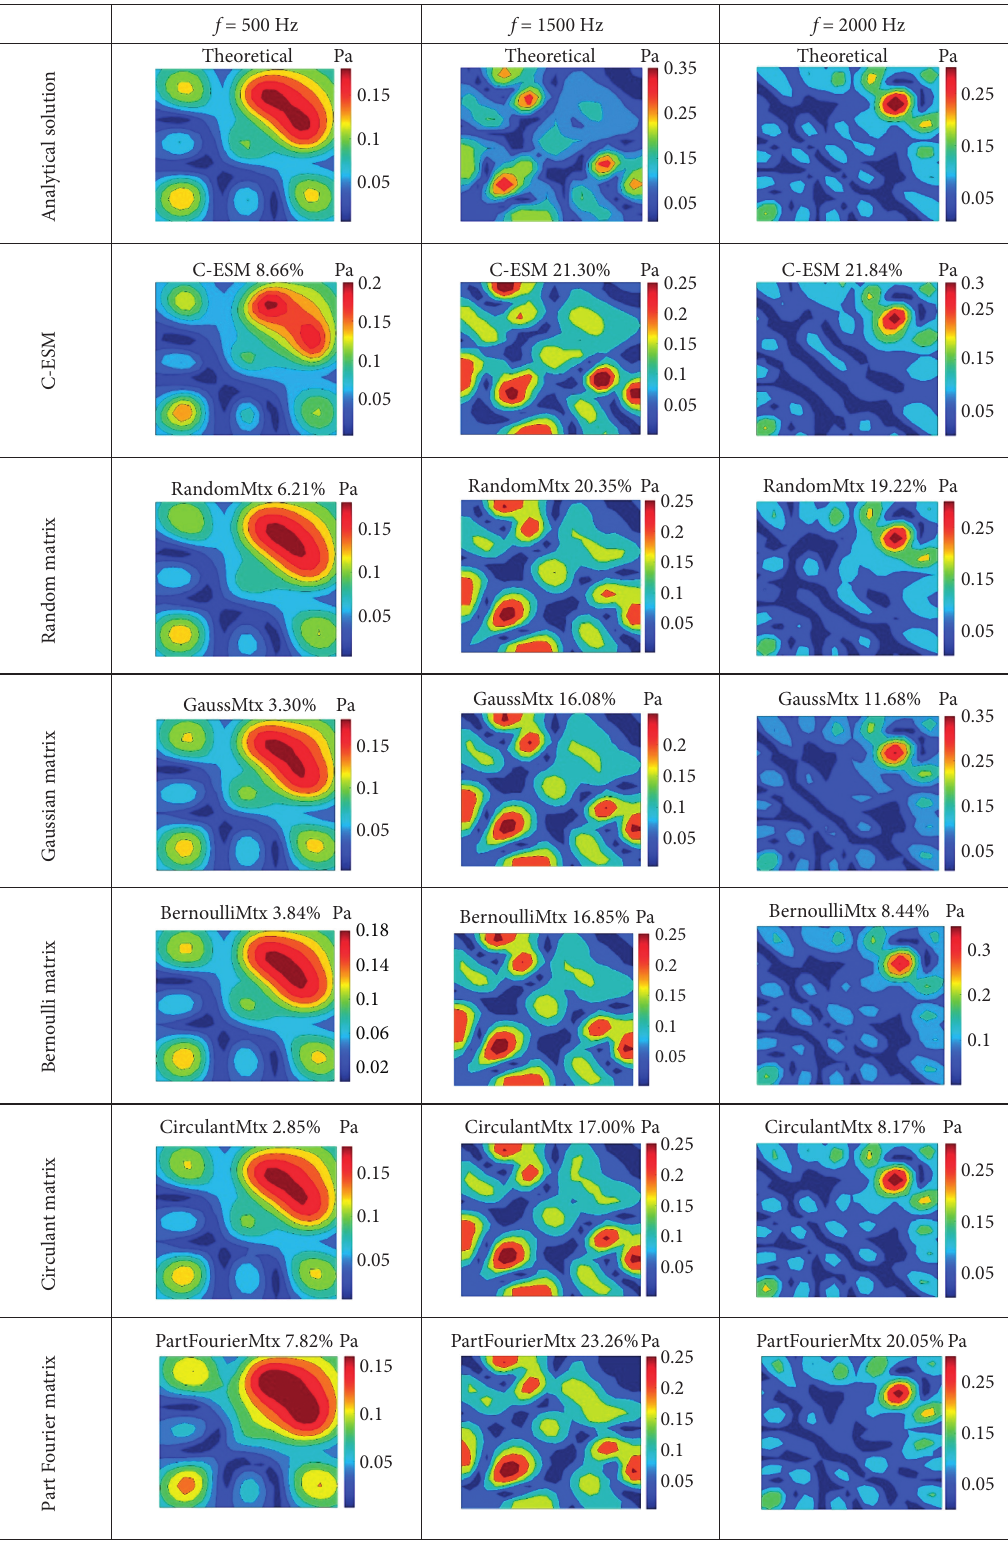
Figure 7: Reconstructed and theoretical acoustic pressure nephogram of six methods with 64 sampling